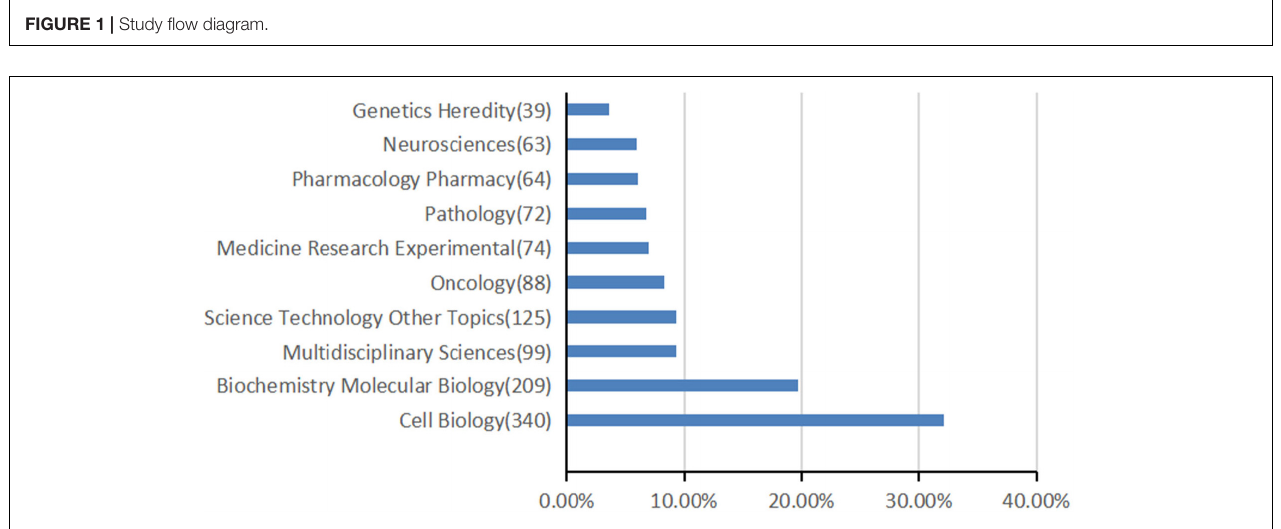
FIGURE 2 | The top 10 most frequently appearing research areas in TFEB